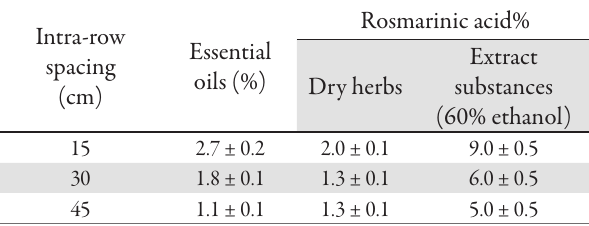
Tab. 2. Essential oil and rosmarinic acid content of sage